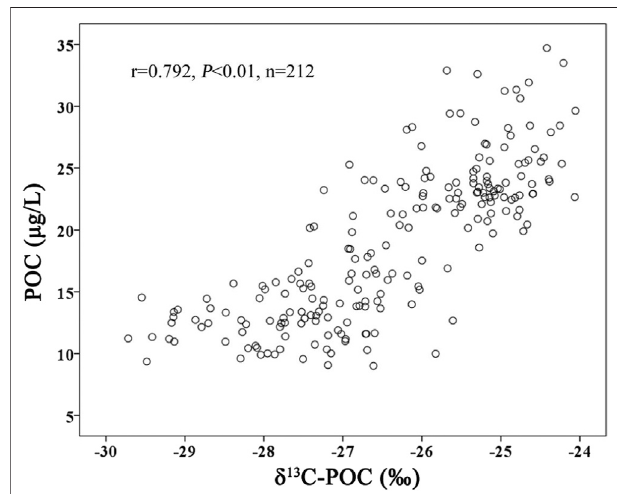
FIGURE 4 | Relationship between POC and δ 13 C-POC. The POC and δ 13 C-POC showed a signi fi cantly positive correlation (r (cid:2) 0.792, p < 0.01, n (cid:2) 212), indicating that they had a similar vertical